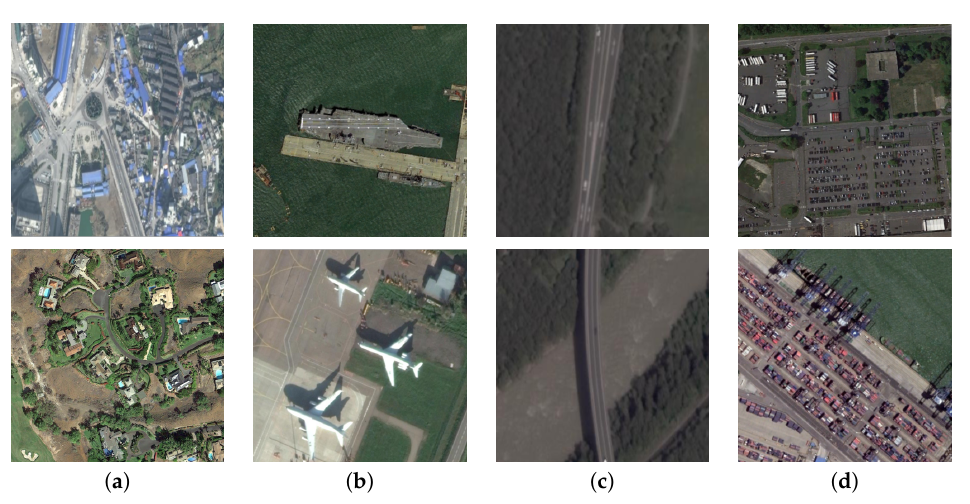
Figure 1. The characteristics of aerial images: ( a ) The complex backgrounds make it difficult to distinguish the targets. ( b ) Aircraft and ship targets with large scale changes. ( c ) An example of how it is easier to distinguish bridges and roads based on scene information. ( d ) Densely arranged targets with angles make it difficult to represent the targets by regular bounding